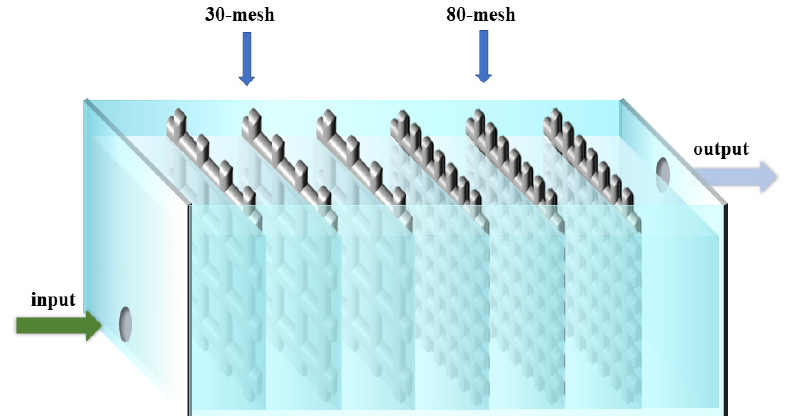
Figure 4. Schematic diagram of the improvement of the treatment pool of the DEP device.